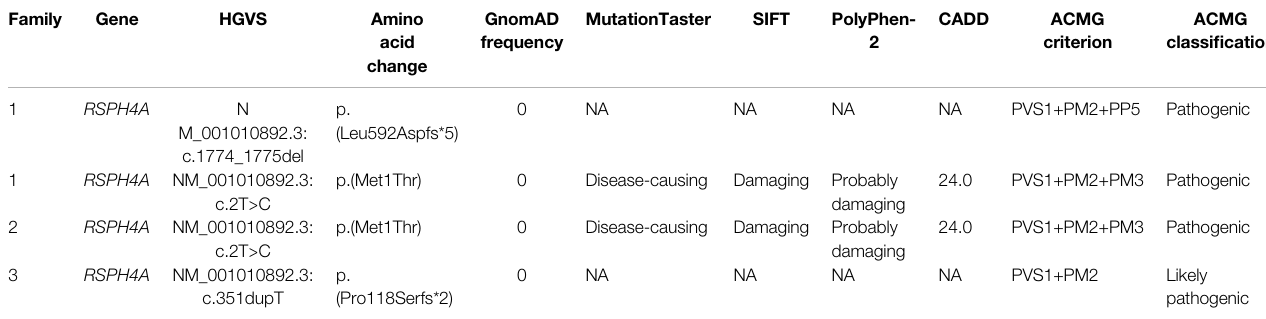
TABLE 2 | RSPH4A variants identi fi ed by exome sequencing for the three families. Family